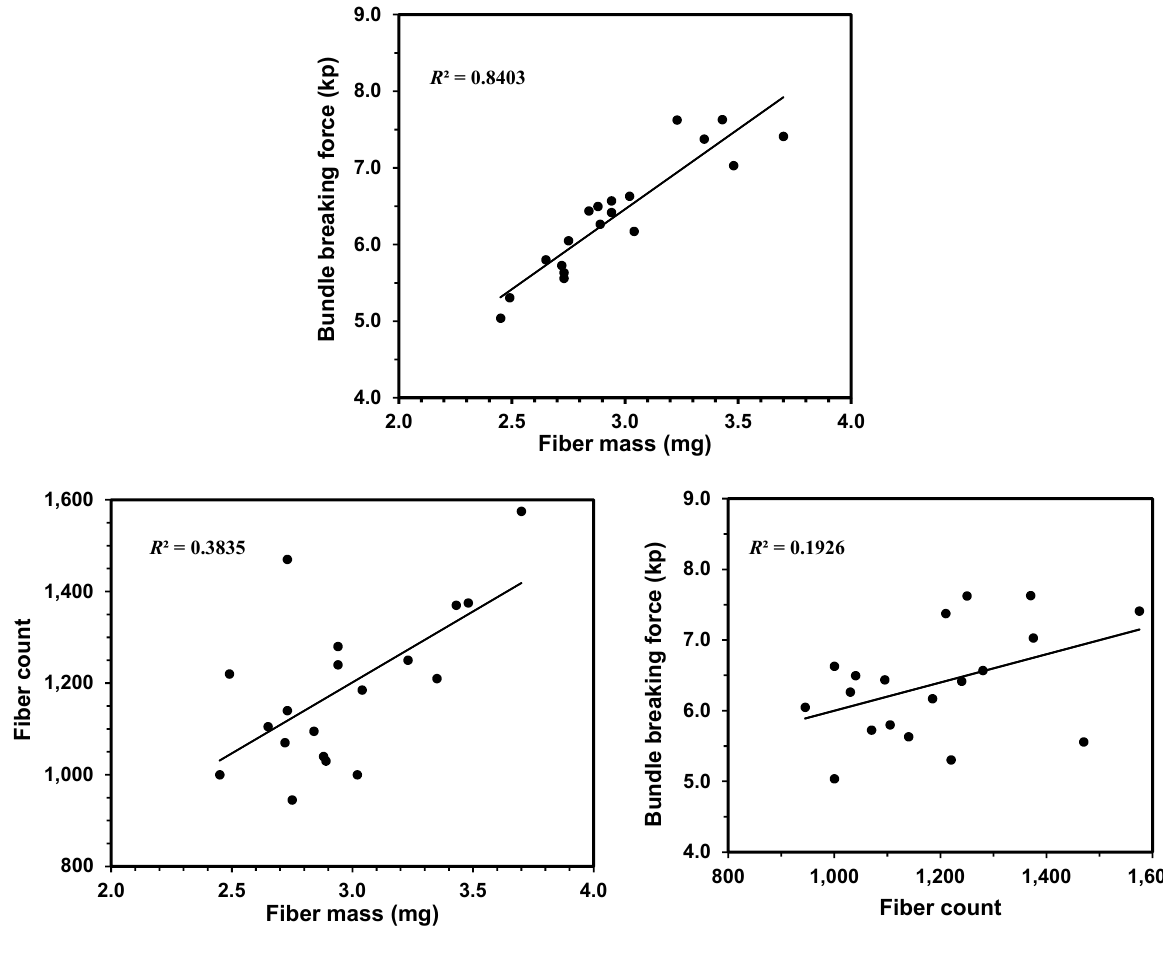
( b ) relationship between fiber count and fiber mass; (c) relationship between fiber